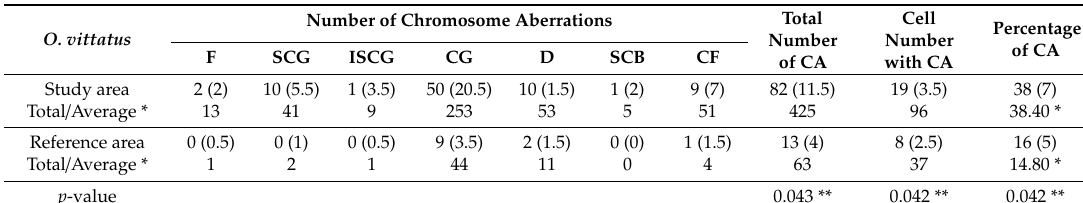
Table 6. Total number of chromosome aberrations, cell number with chromosome aberrations and percentage of chromosome aberrations of O. vittatus from the Nam Kok river near the Sepon gold-copper mine as the study area and the Nam Souang river as the reference area (median (interquartile range), n =